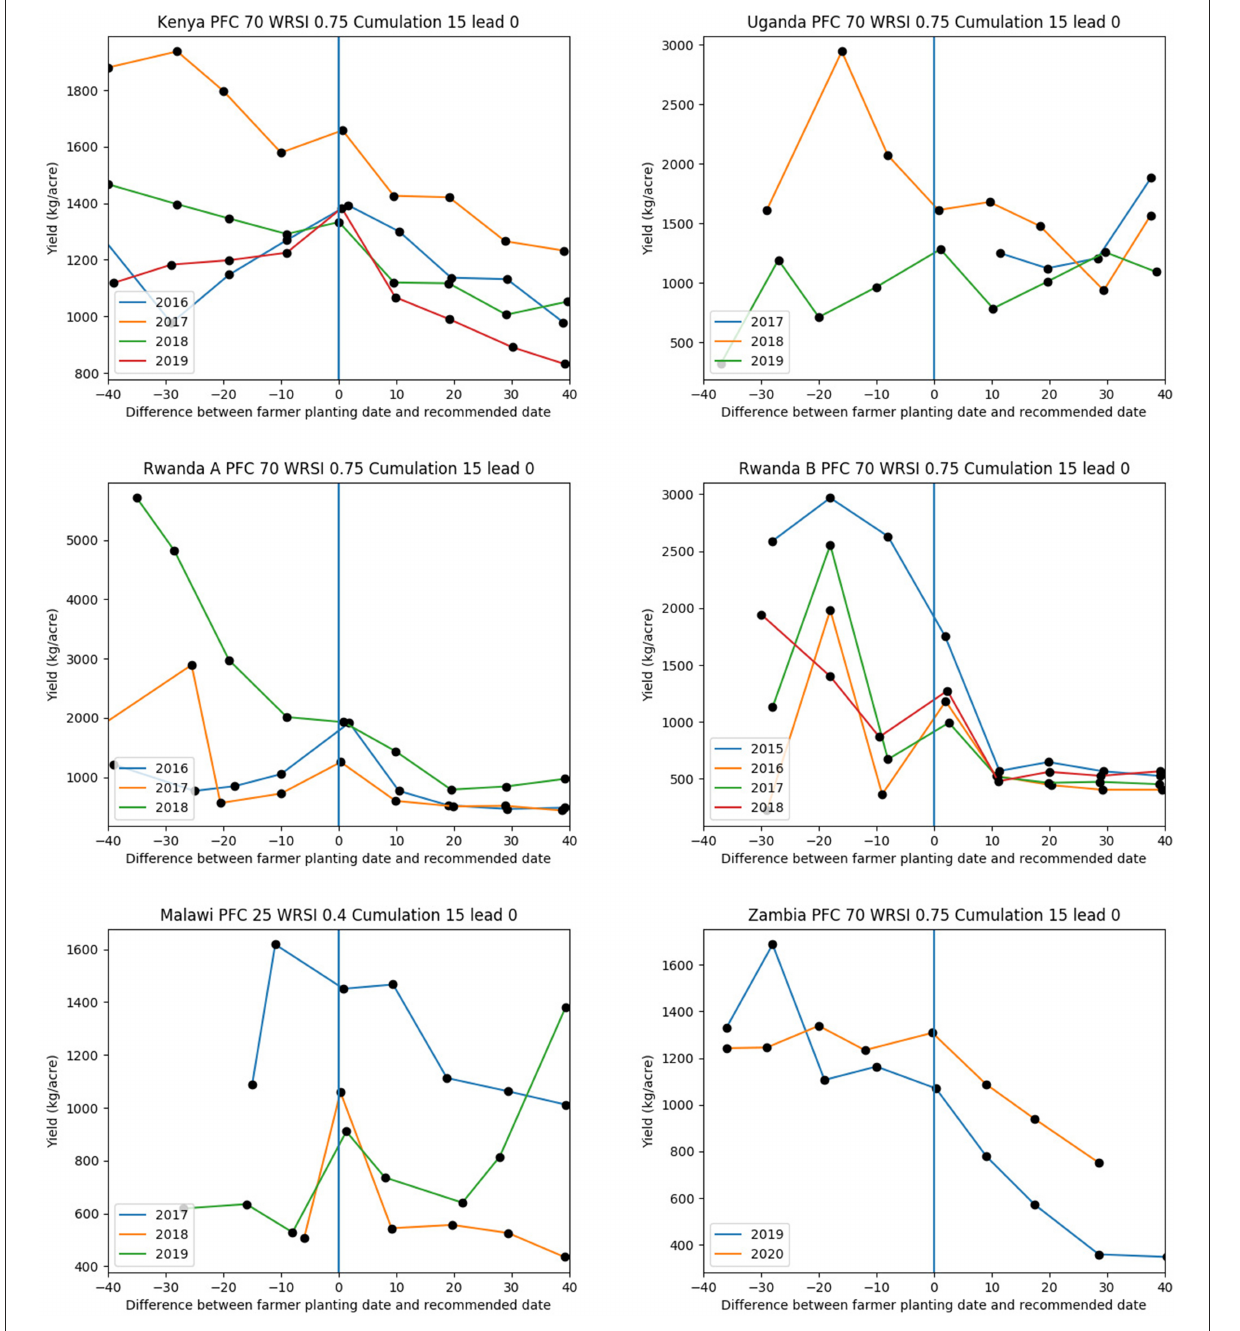
FIGURE8 Yield plotted against the difference between the actual and recommended planting time for individual countries–data collated from all seasons for which we have data. Red dots denote yields that are significantly different to yields within the − 5 to 5 day bin.